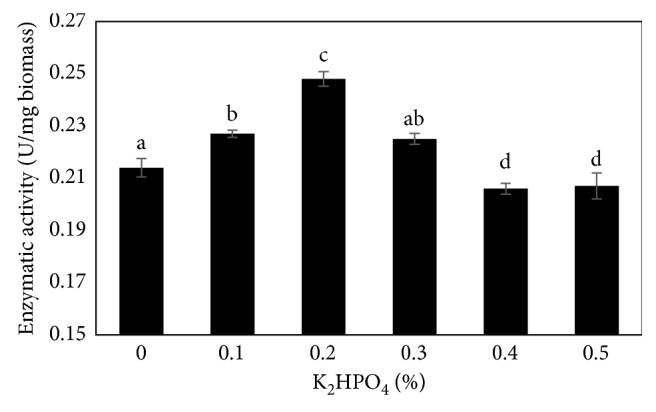
The effect of the concentration of K2HPO4 on glucose isomerase production. Enzyme activity was significantly increased after supplement with 0.2% of K2HPO4 as compared to medium without K2HPO4. However, we observed a decline of enzyme activity while the concentration of K2HPO4 was adjusted from 0.3 to 0.5% (0.225 ± 0.002 and 0.207 ± 0.005 U/mg biomass, accordingly, p < 0.05). We chose the optimal concentration of K2HPO4 is 0.2%. a, b, c, and d indicate the significant difference between groups.